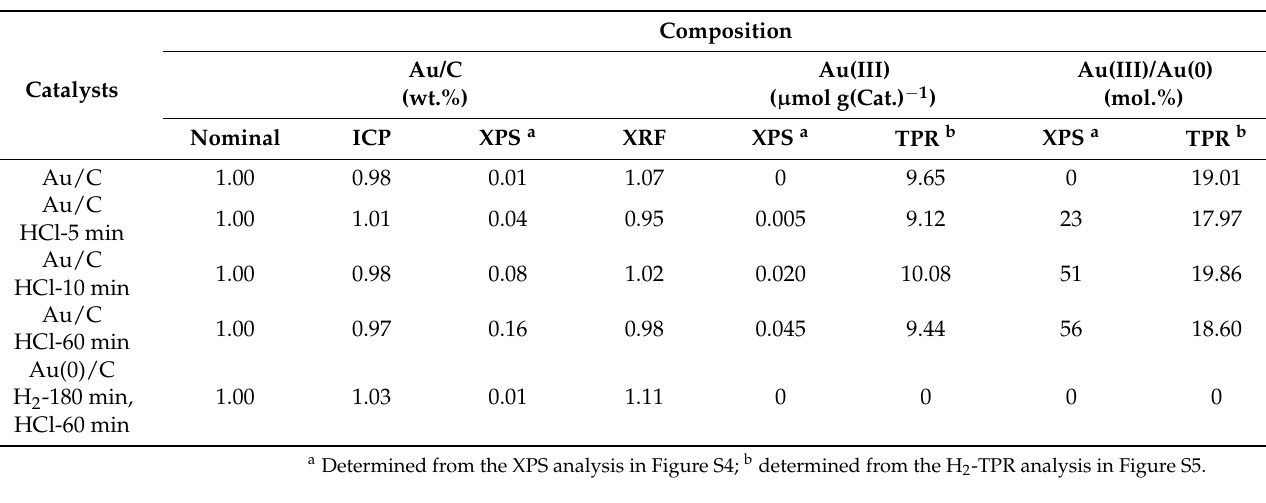
Table 1. Surface and bulk composition of Au/C catalyst.